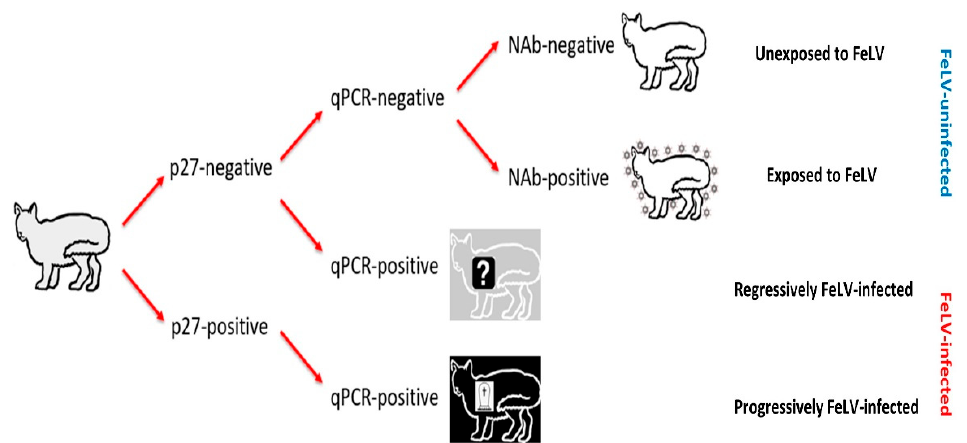
Figure 1. Algorithm used for classifying the FeLV exposure and infection status of cats recruited for the current study (grey cat with black outline). Cats unexposed to FeLV are represented as a white cat with a black outline; FeLV-uninfected cats that had been exposed to FeLV (NAb-positive; abortive infections) are represented as a white cat with a black outline and surrounded by FeLV, to demonstrate their robust immune response to clear early FeLV infection and protect them from further FeLV challenge; presumptively regressively infected cats are represented as a grey cat with a white outline and a question mark to represent a possible predisposition to developing lymphoma; and presumptively progressively infected cats are represented as a black cat with a white outline and a tombstone to represent their poor prognosis. FeLV-infected cats were classified as “presumptively” infected since testing was only performed at a single time point. NAb = neutralising antibody, qPCR = real-time polymerase chain reaction.